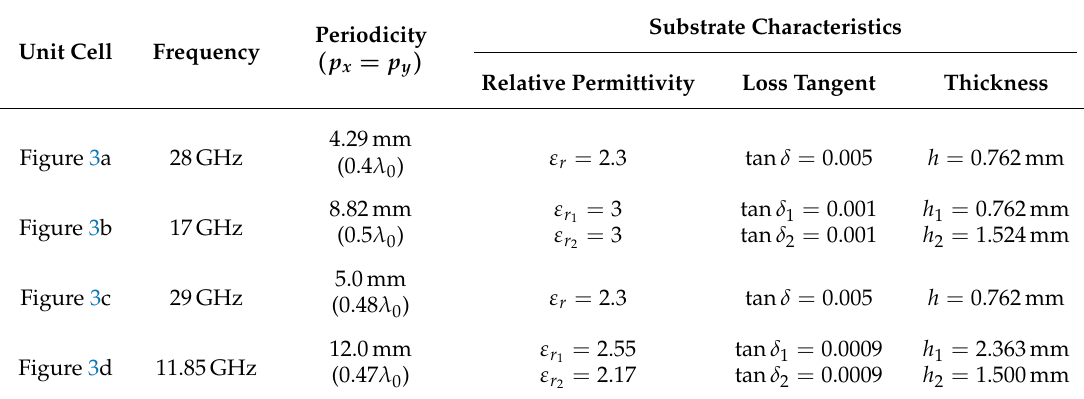
Table 1. Characteristics of the unit cells shown in Figure